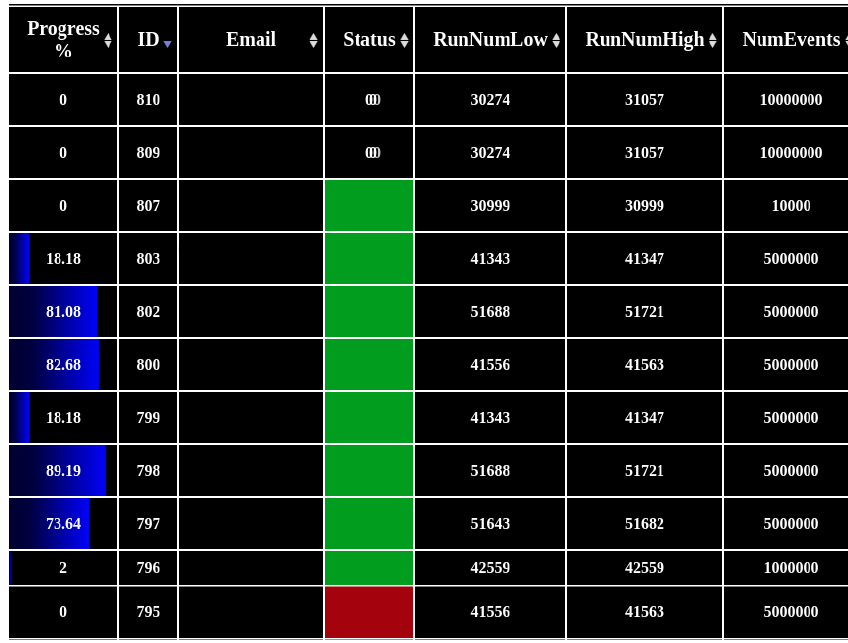
Figure 3. Shown is part of the dynamic dashboard (emails have been redacted to protect user infor- mation). Each request has a progress bar which updates in near real time without the need for page reloading. The Status column shows failed tests (red), successfully tested and running projects (green), and projects currently being tested (an animated ellipses). The rest of the table shows basic information about the request. The rows can be right-clicked to interact with the project (user’s options are privilege dependent). Left-clicking on a row generates additional tables with more detailed information. Not shown are heart beats from the components of the automated system, the current load as seen from the submit host, and a world showing the geo-locations of the current active projects or, if a project has been selected, the scraped geo-location of the selected project’s